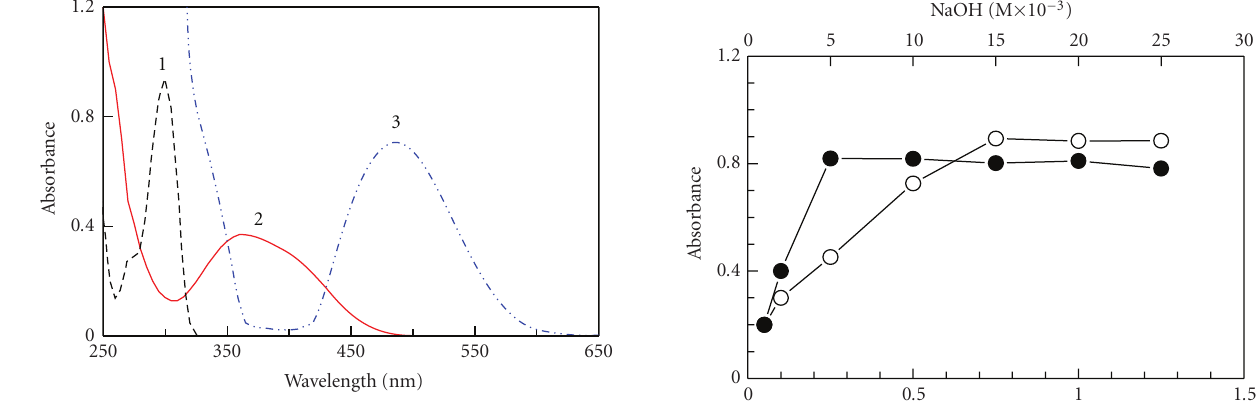
Figure 1: (1) Absorption spectra of PRX against water, (2) NQS against water, and (3) their reaction product against reagent blank.